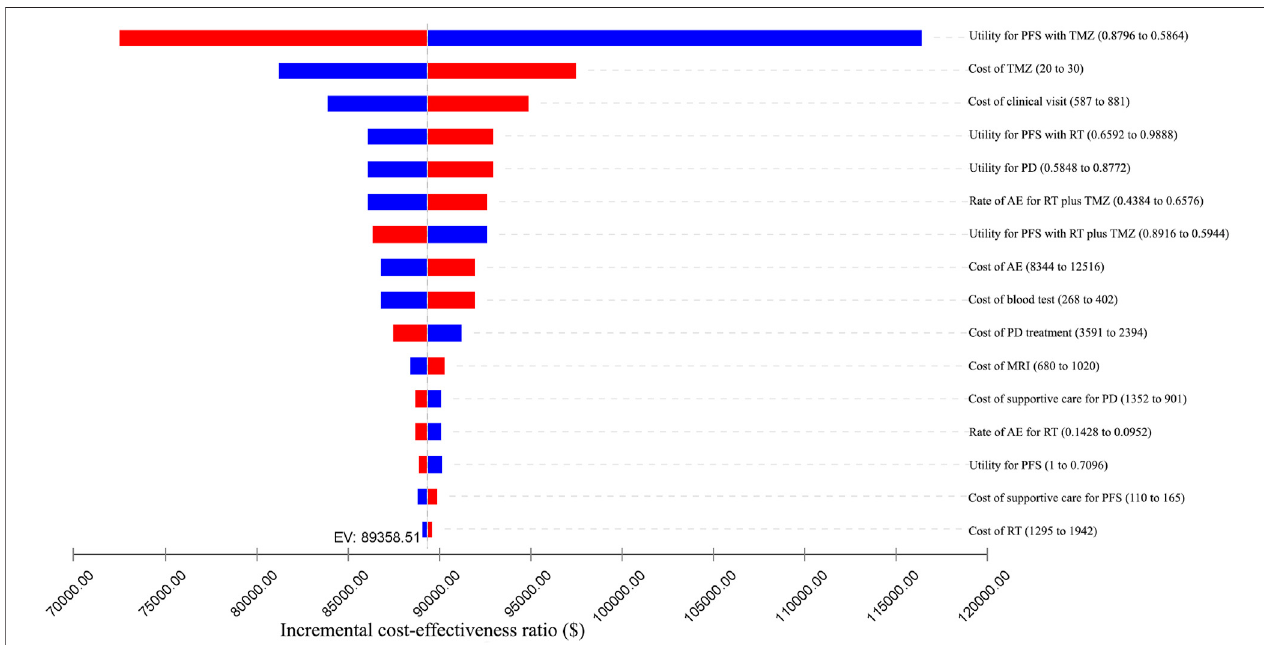
FIGURE 3 | One-way sensitivity analyses from the US perspective. AE: adverse event; EV: expected value; MRI: magnetic resonance imaging; PD: progressive disease; PFS: progression-free survival; RT: radiotherapy; TMZ: temozolomide.